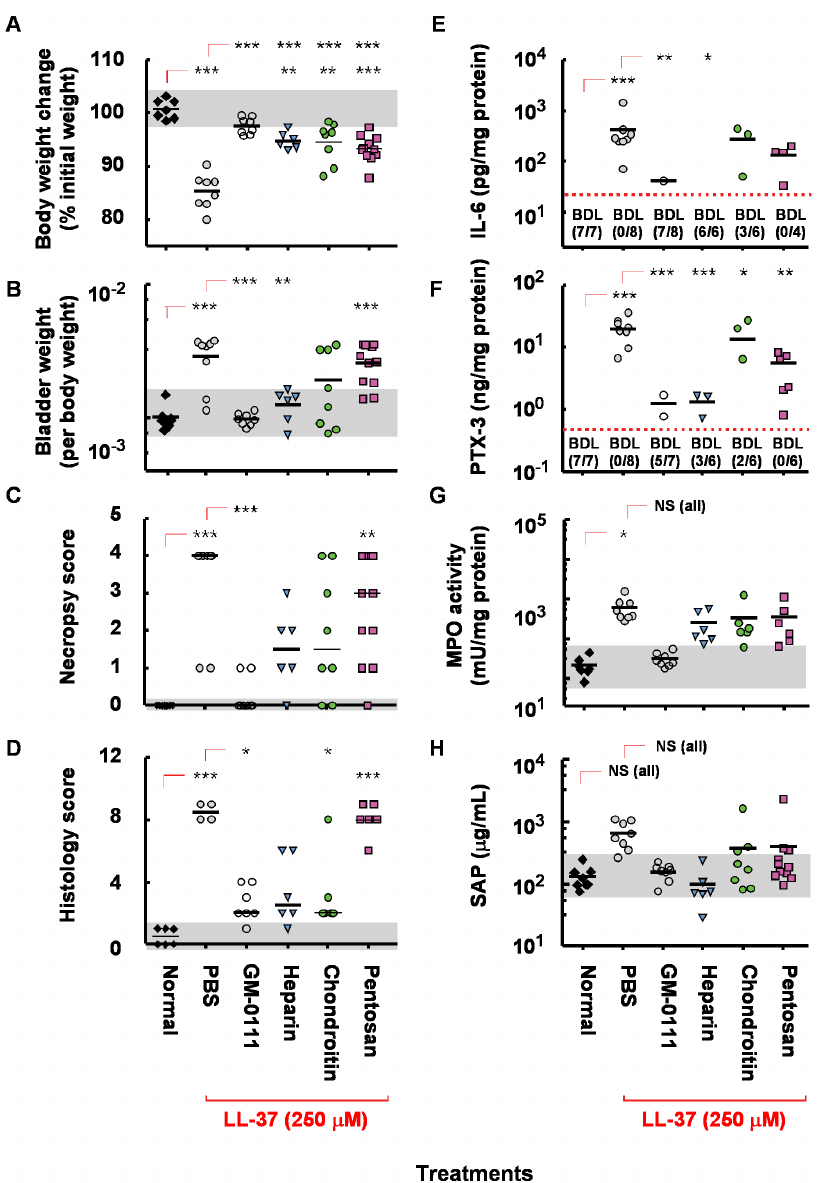
Figure 7. The protective effects of GM-0111 and heparin against LL-37 induced cystitis are more powerful than chondroitin sulfate or pentosan polysulfate. The animals receiving each compound at 100 mg/mL dosage by intravesical instillation prior to LL-37 instillation showed markedly reduced clinical signs of IC and decreased molecular markers in the serum and tissues. * p , 0.05, ** p , 0.01, and *** p , 0.001 compared to either normal or PBS/LL-37 instilled control group. NS, not significant ( p . 0.05) by Dunnet’s t-test. Black horizontal bars are the mean or median (necropsy and histology scores) values. BDL and the values in the parenthesis represent the number of samples that fell below the detection limit (red dotted line) of the ELISA out of the total samples tested. For data analysis purposes, any values below the detection limit were listed as being at the detection limit, which may in some cases overestimate the numerical value. Gray area represents the range of values found in normal animals.